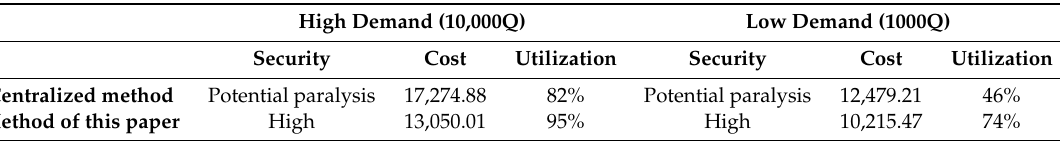
Table 5. Demand based scenario comparison.